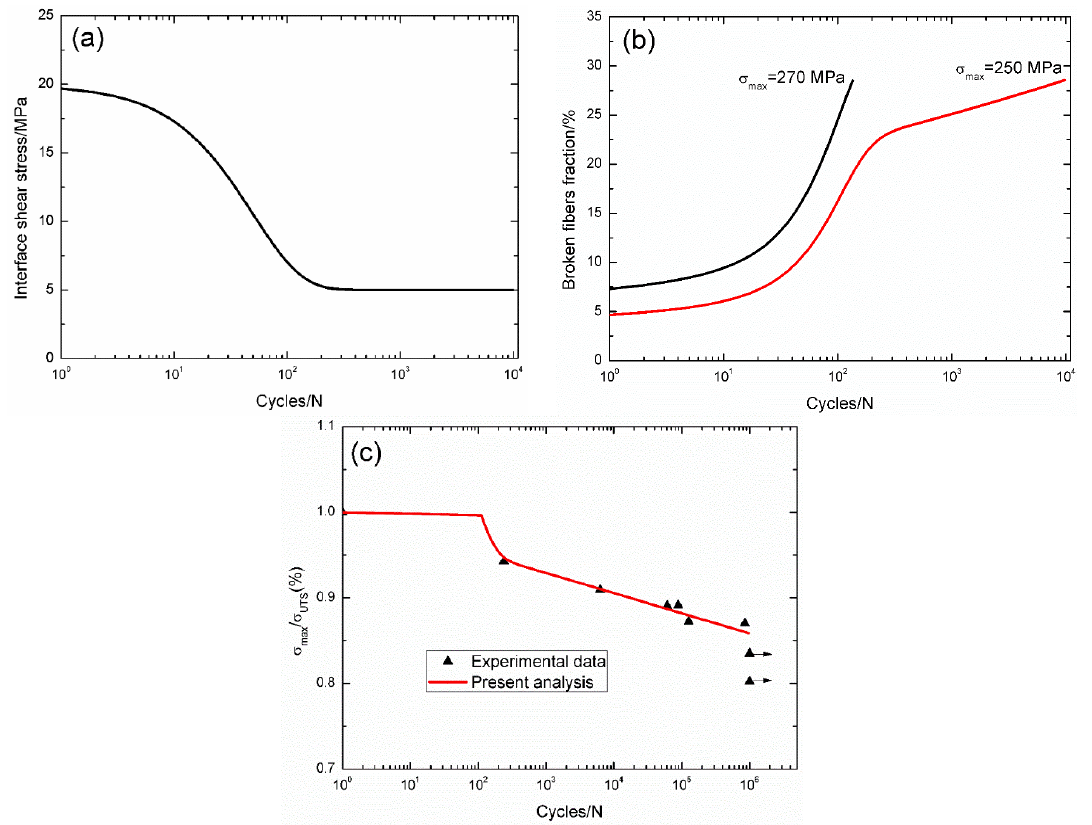
Figure 8. ( a ) The interface shear stress versus applied cycles; ( b ) the broken fibers fraction versus applied cycles; and ( c ) the fatigue life S–N curves of experimental data and theoretical analysis for 3D C/SiC composite at room temperature.